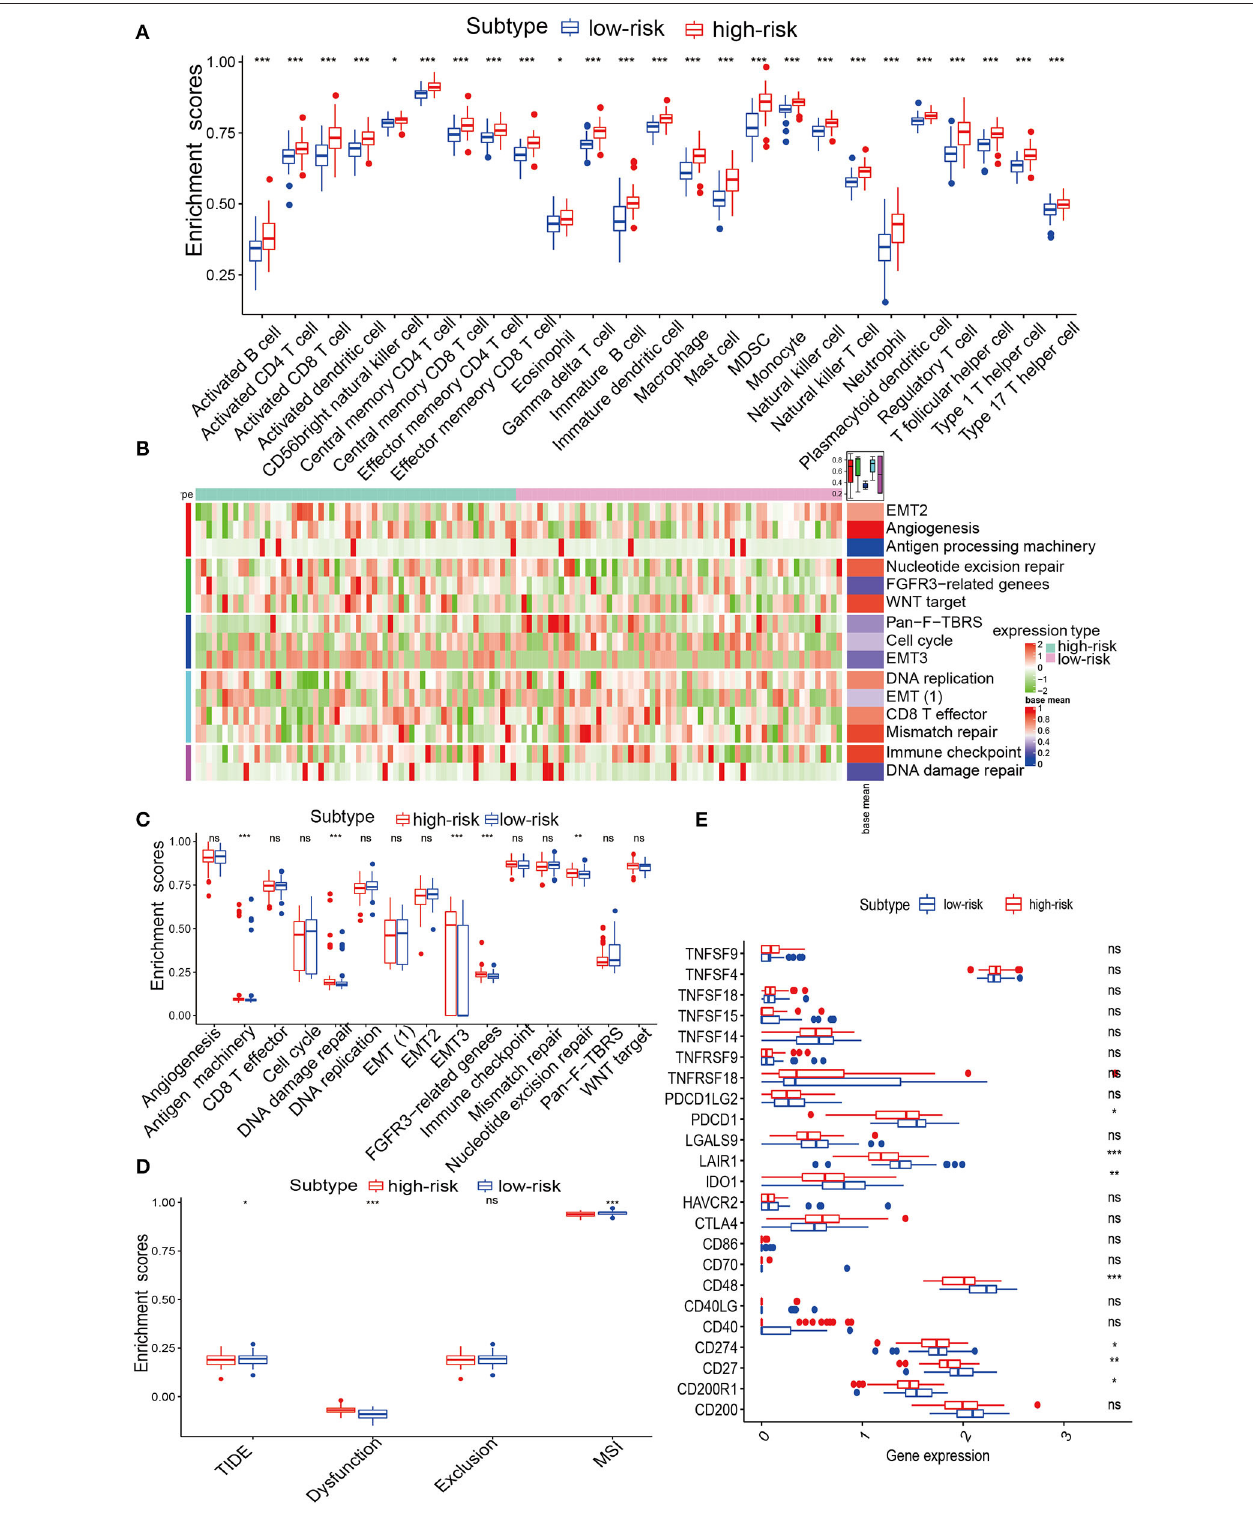
FIGURE 5 | Immune infiltration analysis of IRPM in TCGA. (A) Abundance differences in immune cells between both groups in the TCGA-GBM cohort. (B) Heatmap showing the distribution of immune pathways in both groups. (C) The abundance of distinction in immune pathways between both groups in the TCGA-GBM cohort. (D) TIDE, MSI, and T cell exclusion and dysfunction score in IRPM. Comparison of scores between IRPM by Wilcoxon test. (E) Quantification of immune checkpoints in both groups in the TCGA-GBM cohort.